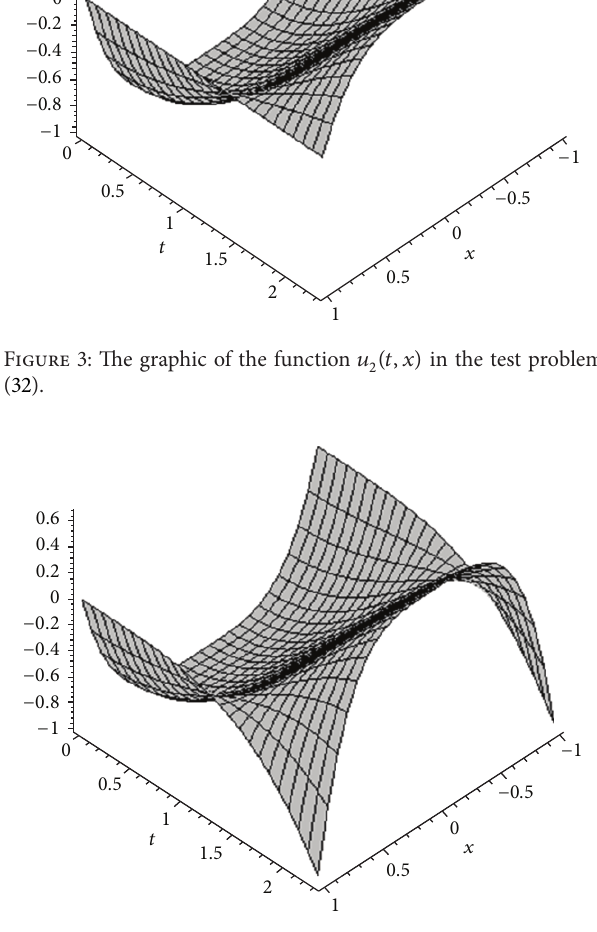
Figure 4: The graphic of the function 𝑢 ∗ 2 (𝑡,𝑥) in the test problem